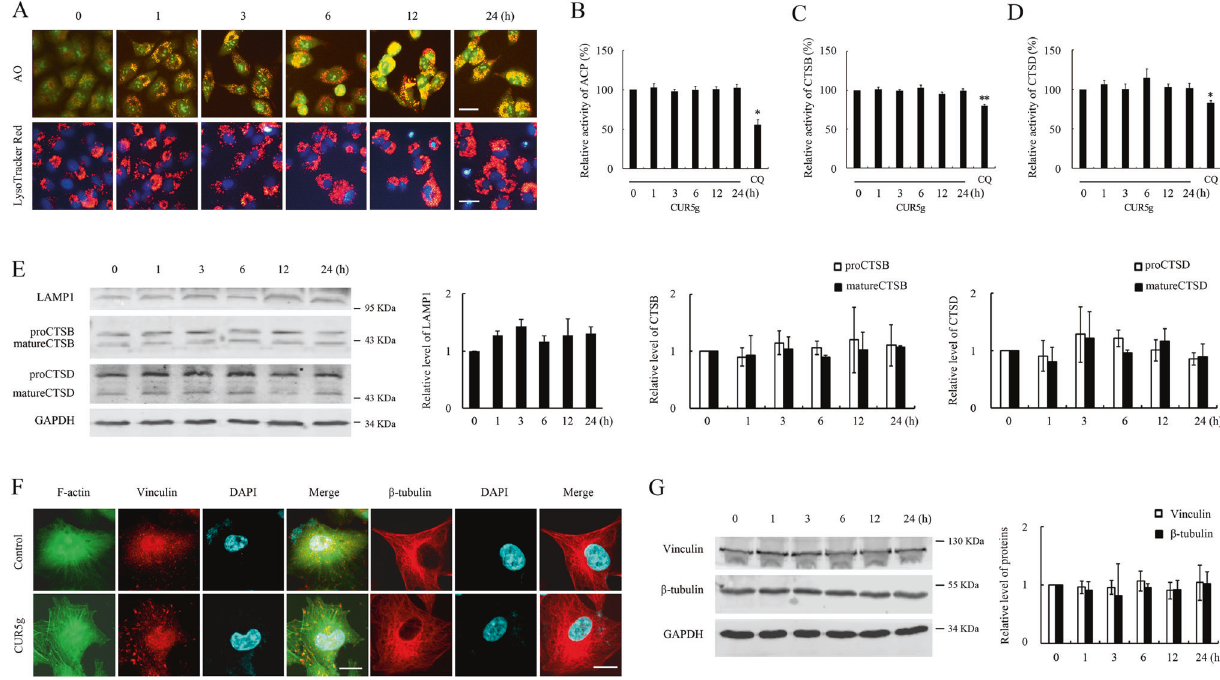
Fig. 3 CUR5g does not impair the lysosomal proteolytic function and cytoskeleton. A Representative fl uorescence photographs of acridine orange (AO) staining and LysoTracker Red staining of A549 cells treated with CUR5g (10 μ M) for 0 – 24 h. Scale bar = 10 μ m. B – D Relative enzymatic activity of ACP ( B ), CTSB ( C ), and CTSD ( D ) in A549 cells treated with CUR5g (10 μ M) for 0 – 24 h. CQ (30 μ M)-treated cells were used as positive controls. ( n = 3; * p < 0.05; ** p < 0.01 vs. 0). E Western blot analysis of LAMP1, CTSB, and CTSD levels in A549 cells treated with 10 μ M CUR5g for 0 – 24 h. GAPDH was used as a loading control. F Representative fl uorescence photographs of the localization of F-actin (green), vinculin (red), and β -tubulin (red) in A549 cells treated with DMSO or CUR5g (10 μ M) for 24 h. Nuclei were stained with DAPI. Scale bar = 10 μ m. G Western blot analysis of vinculin and β -tubulin levels in A549 cells treated with 10 μ M CUR5g for 0 – 24 h. GAPDH was used as a loading